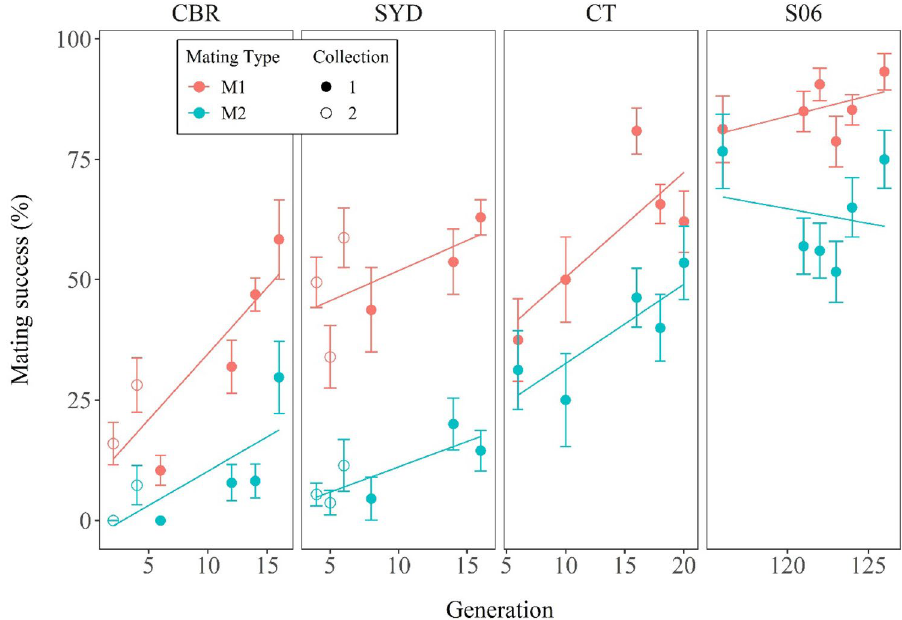
Figure 2. Changes in the mating and remating frequencies of the three wild/caught populations and S06 over generations in Experiment 1. The data for the -1 and -2 collections of CBR and SYD are shown with filled and open symbols respectively. Standard errors are also shown. Lines of best fit for each population across generations are given for both M1% (red) and M2% (blue). Numbers of females tested per strain and generation were 32–211 for M1 and 30–92 for M2.